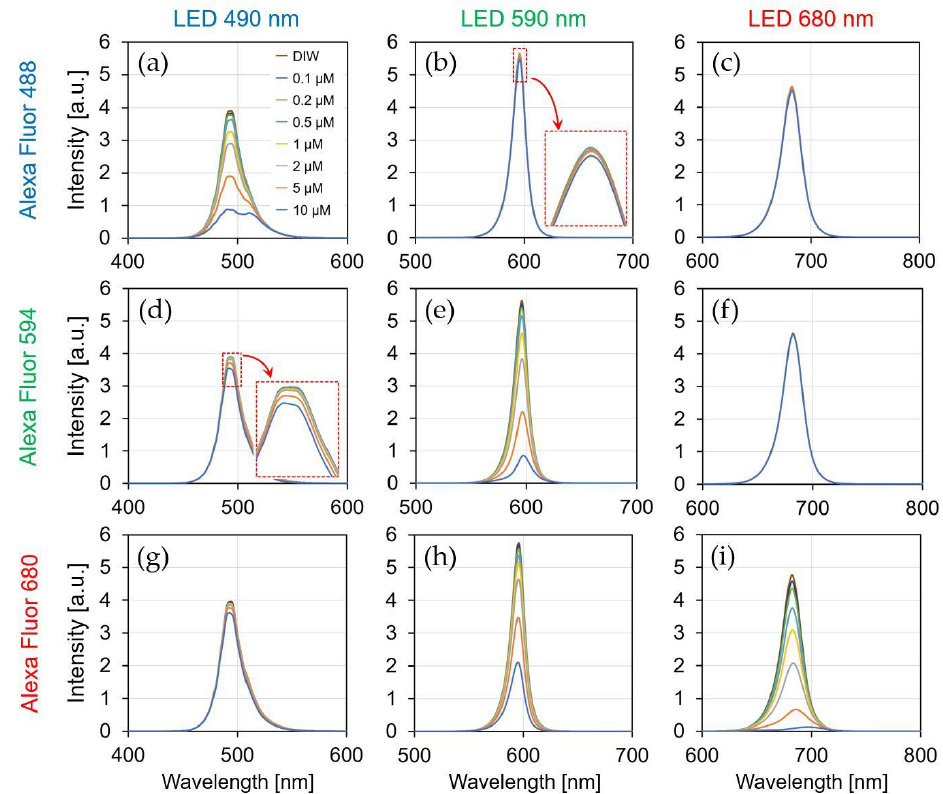
Figure 12. Spectral characteristic by the concentration of fluorescent reagent. ( a ) AF488- λ em : 490 nm; ( b ) AF488- λ em : 590 nm; ( c ) AF488- λ em : 680 nm; ( d ) AF594- λ em : 490 nm; ( e ) AF594- λ em : 590 nm; ( f ) AF594- λ em : 680 nm; ( g ) AF680- λ em : 490 nm; ( h ) AF680- λ em : 590 nm; ( i ) AF680- λ em : 680